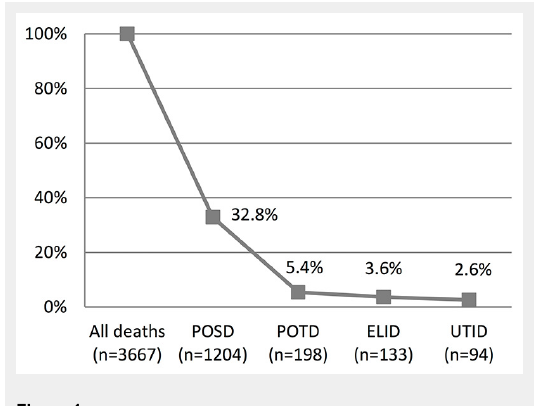
Losses by step in the donation process. ELID = eligible donor; POSD = possible donor; POTD = potential donor; UTID = utilised donor